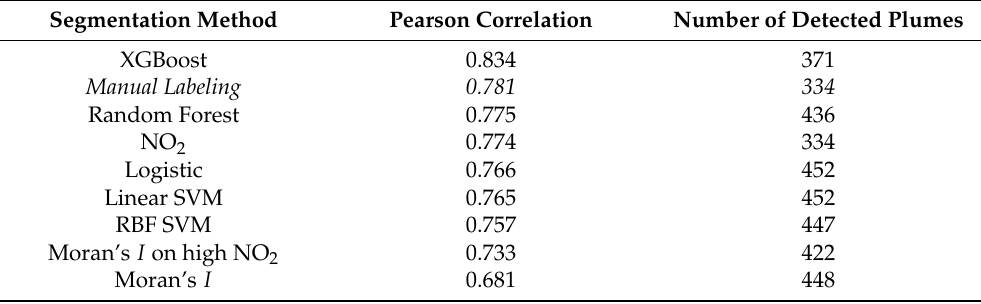
Table 4. Results on the comparison between the estimated amount of NO 2 and theoretically derived NO x ship emission proxy. Sorted in accordance with the achieved level of the Pearson correlation. Italic font indicates baseline